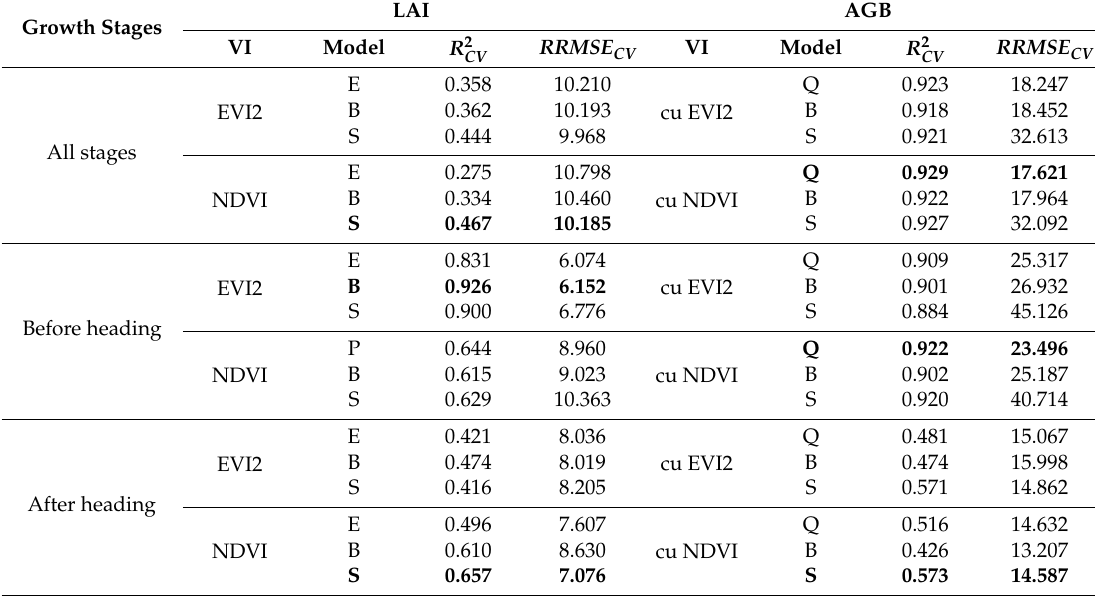
Table 4. Results of regression models at different single-cropped rice (SCR) growth stages.